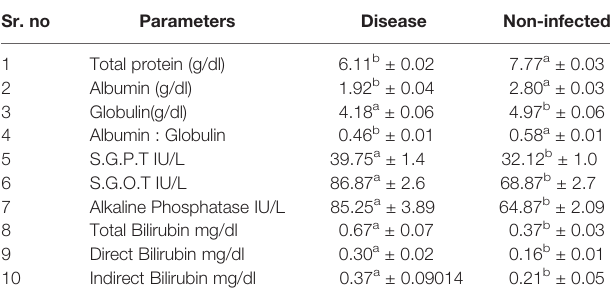
The Mean values that have superscript, was showingsigni fi cant difference between groups. The superscript ‘ a ’ was showing high mean value than ‘ b ’ . Signi fi cant at (p ≤ 0.05).